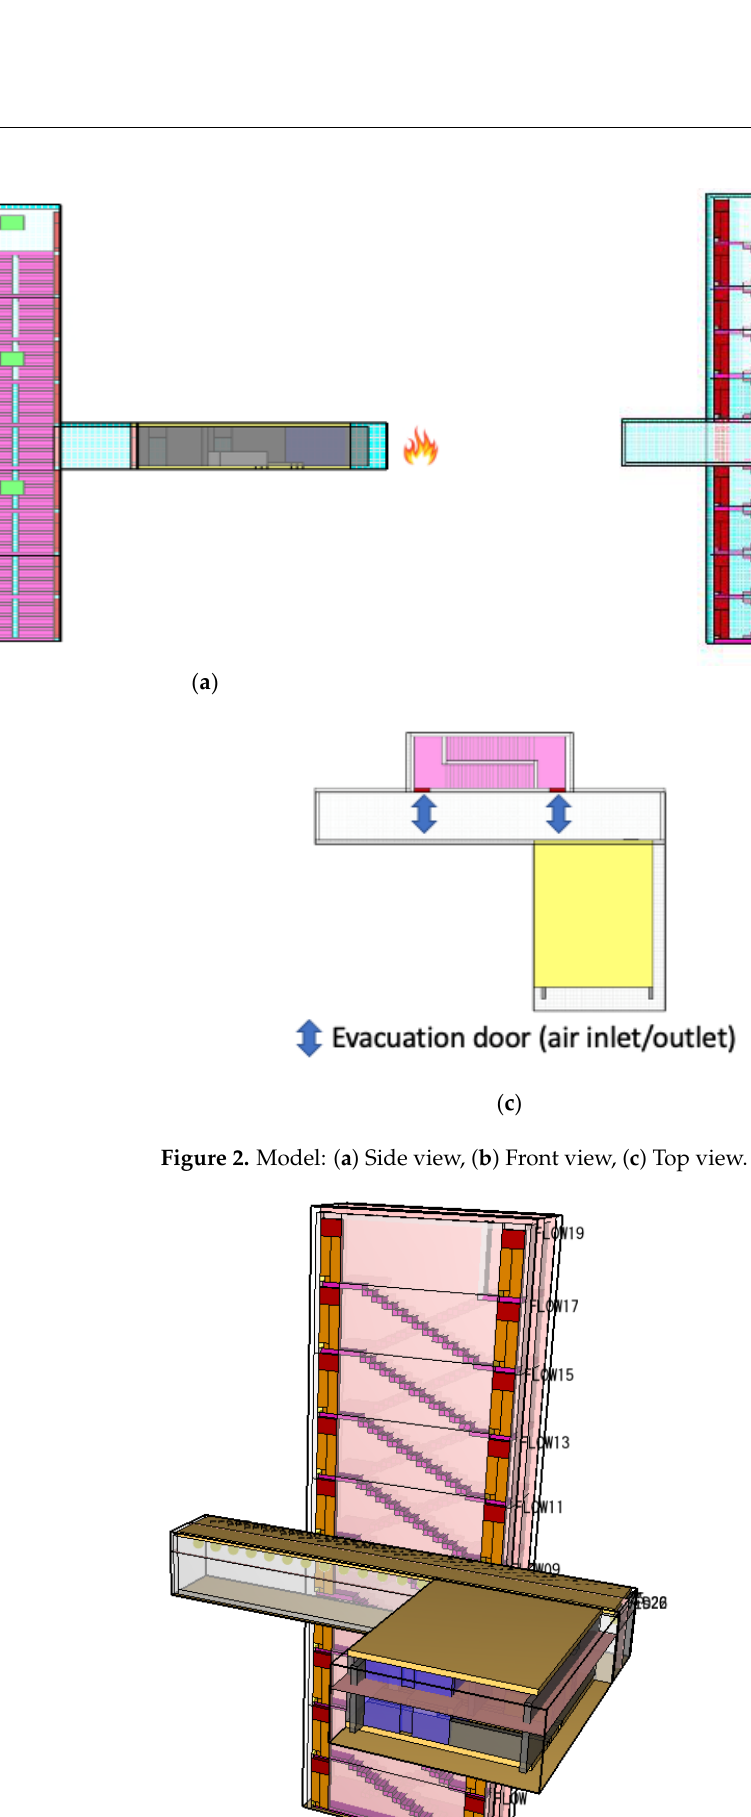
Figure 3. Complete model extent.